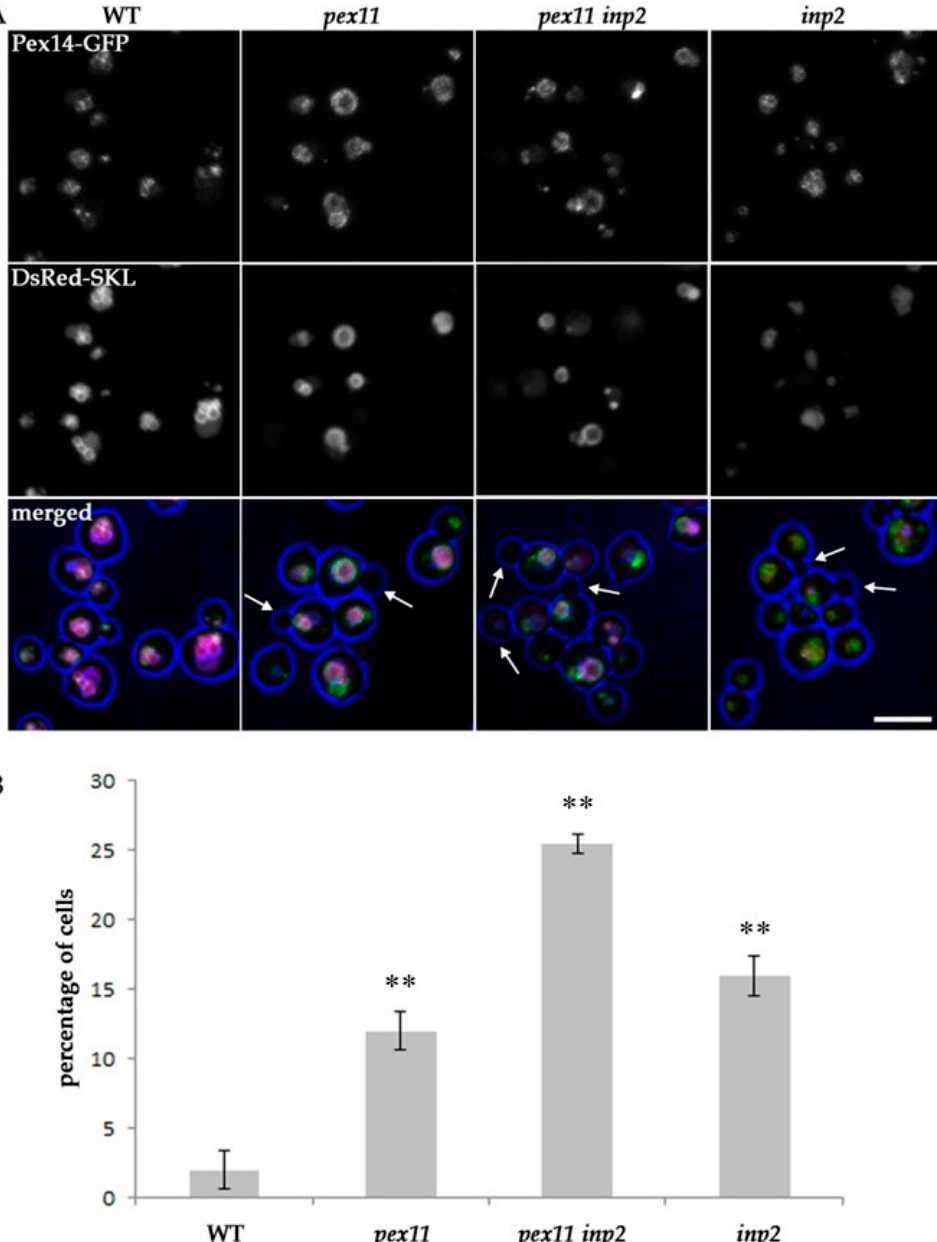
Figure 4. Block of fission and inheritance has an e ff ect on the percentage of cells lacking any peroxisomal structures. ( A ) Examples of CLSM images used for the quantification shown in ( B ). Wild type (WT), pex11 , pex11 inp2 and inp2 cells producing Pex14-mGFP and DsRed-SKL were grown for 16 h on methanol medium. Arrows point to the cells that lacked a Pex14-GFP spot. The scale bar represents 5 µ m. ( B ) Graph representing percentage of cells lacking Pex14-GFP spots in the indicated strains. Both mother cells and buds, with a diameter comprising at least 1 / 3 of corresponding mother cell’s diameter, were included in the analysis. Quantitative data were obtained from two independent cultures of each strain. The percentages were calculated from 100 cells per culture. The error bars represent the standard deviation. The number of cells lacking Pex14-GFP spots was significantly higher in pex11 , pex11 inp2 and inp2 strains compared to WT cells (** p < 0.01).